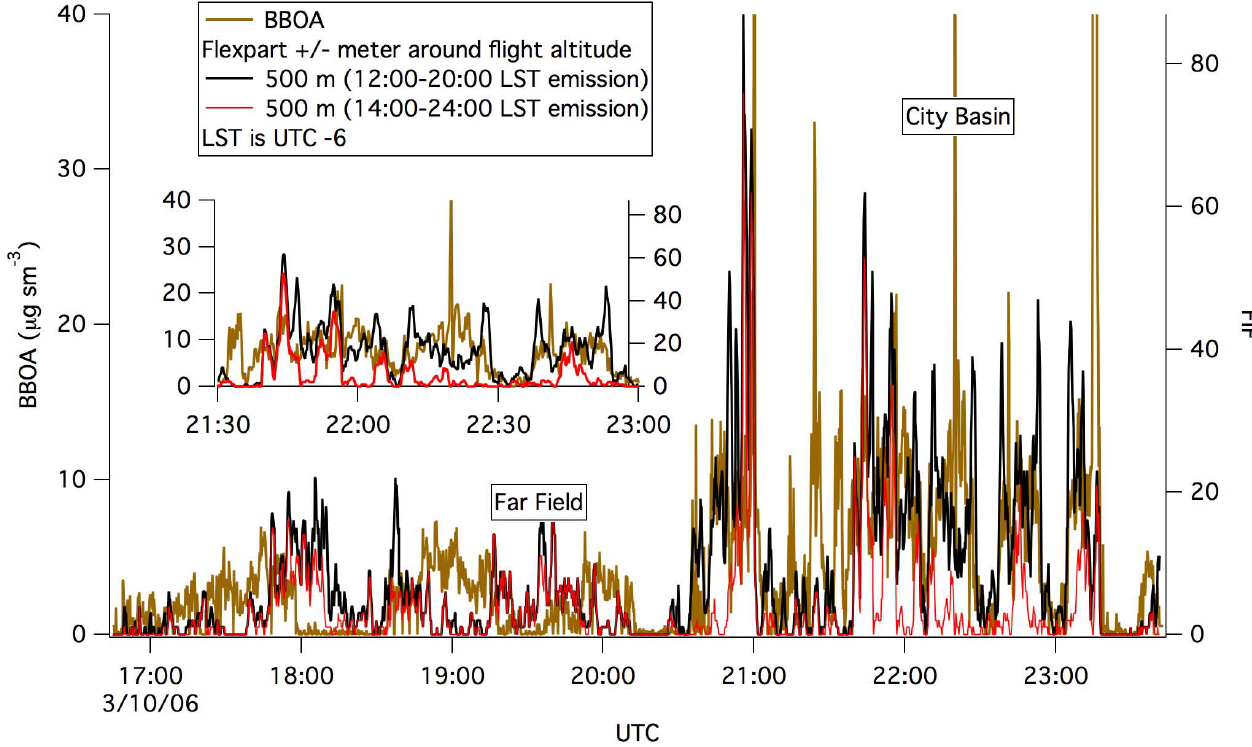
Fig. 8. Shown here is the timeseries of the BBOA factor from PMF analysis with the FIF calculated from WRF-FLEXPART modeling. The two diurnal fire emission scenarios for the +/ − 500m vertical integration for FIFs around the aircraft altitude are given. The inset shows a zoom of a portion of data within the MCMA